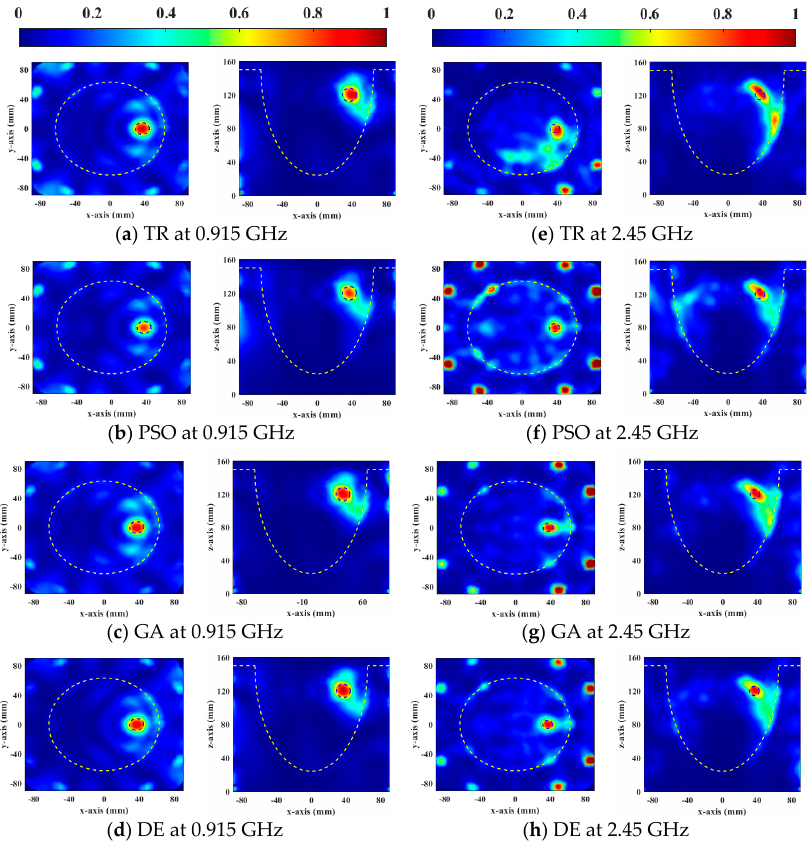
Figure 2. Normalized SAR distribution in axial (XY) and coronal (XZ) planes of a general breast model optimized using four FMHT optimization methods.